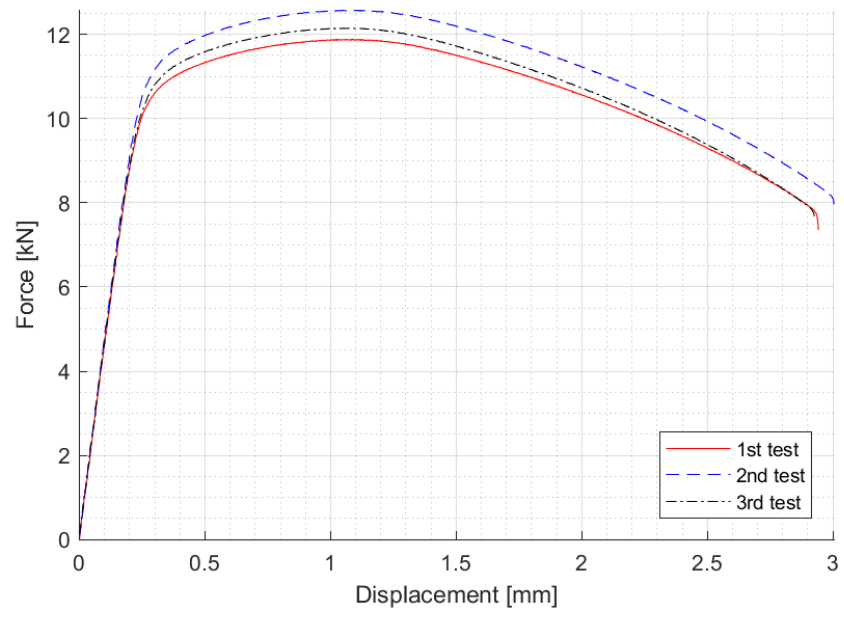
Figure 3. Results of the tensile test (ASTM E8/E8M).